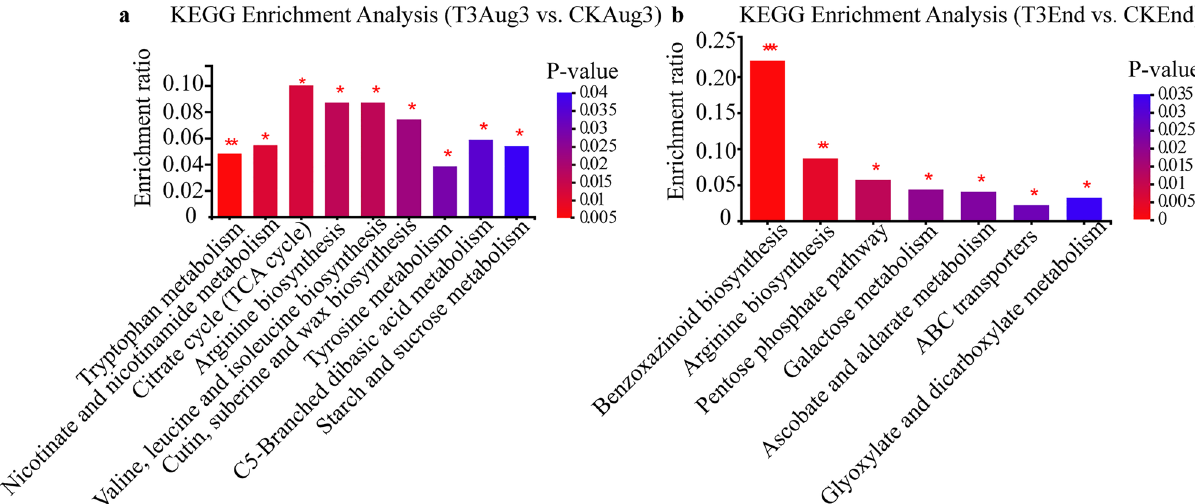
Figure 6. KEGG pathway enrichment analysis based on differentially abundant metabolites 21 . ( a ) T3Aug3 vs. CKAug3. ( b ) T3End vs. CKEnd. The horizontal coordinate is the name of the pathway, and the vertical coordinate indicates the enrichment ratio, which represents the ratio of the number of metabolites enriched in the pathway to the number of metabolites annotated to the pathway. T3Aug3 (samples from the T3 treatment on August 3rd), CKAug3 (samples from the CK treatment on August 3rd), T3End (samples from the T3 treatment on September 2nd) and CKEnd (samples from the CK treatment on September 2nd). A P value < 0.001 is marked ***, a P value < 0.01 is marked **, and a P value < 0.05 is marked (nonfluorescent chlorophyll catabolites), FCCs (fluorescent Chl catabolites) and RCCs (red Chl catabolites) are produced by chlorophyll degradation-related enzymes 24,25 . The green spots that occurred in the tobacco leaves of the wrapper variety CX-010 produced in the Enshi tobacco planting area directly impacted the consistency of the color of the tobacco leaves, thus affecting the availability of raw materials for cigars. In our study, spraying exogenous sucrose effectively limited the occurrence of green spots (Figs. 1,2). Although the fast appearance of green spots was accompanied by rapid water loss in all treatments, the water content of tobacco leaves in order was T3 < CK < T2 < T1, and the number of green spots in order was T3 < T2 < T1 < CK. It has been reported that sucrose possesses a moisturizing function at the appropriate concentrations 26,27 , which could be a possible expla- nation for why the T1 and T2 treatments had a higher total water content relative to the CK, which supported more chlorophyll degradation-related enzymes. However, the T3 treatment caused the largest limitation of green spot occurrence, which cannot be attributed to the change in the total water content. These results suggest that sucrose confers an unknown mechanism modulating the formation of green spots and that the total water content changes might be a result in sucrose concentration changes independent of green spot formation. Zhang et al. reported that the TCA and polyphenols biosynthesis pathways were associated with the response of tobacco plants to various salinity conditions, and the DAMs mainly included tyrosine, tryptophan and critic acid 28 . In this study, we found that the DAMs classification certainly agreed with Zhang’s study, suggesting that these DAMs predominantly occupy the metabolic pathways in leaf senescence. Yu et al. identified three sig- nificantly differentially enriched KEGG pathways in the green spotted tissues compared to the normal tissues, including tyrosine metabolism, phenylalanine metabolism, and flavonoid biosynthesis, and the chlorogenic acid accumulated in green spots as a chemical marker of green spot formation 4 . Chlorogenic acid is the main phenolic substance in tobacco and forms brown pigments such as quinones through enzymatic browning reactions dur- ing the air-curing process to transform the color of leaves 29 . In the present study, we did not find a difference in chlorogenic acid between the T3 treatment and CK (Supplementary Tables 1,2). One possible reason is that the samples used for metabolomics analysis were whole leaf tissue, and green spotted tissue only accounted for a small part. Thus, the dilution effect should be carefully considered in explaining the results of the present study. Tyrosine is an aromatic amino acid that is a precursor to metabolites such as tryptophan and phenylalanine, which finally produce natural products, including pigments, alkaloids, and hormones 30,31 . It was reported that the addition of tyrosine modulated the development of beetroot leaves and increased the carotenoid content 32 . T3 treatment induced the accumulation of phenylpropanoids such as tyrosine, tryptophan and some flavonoids in tobacco leaves; thus, the sucrose-stimulated phenylpropanoids metabolism must play an important role in differentially regulating the senescence and formation of green spots on air-curing tobacco leaves. On the other hand, the TCA cycle is a core pathway involved in the metabolic process of fatty acid synthesis, glucose hypo- plasia, transamination, and the synthesis of purines and pyrimidines 33,34 . Citric acid is the main intermediate metabolite of the TCA cycle, and Zahid et al. suggested that citric acid promoted plant growth and enhanced plant photosynthesis, thereby promoting chlorophyll formation 35 . All these results suggest that citric acid, tyrosine, and some metabolic pathways are involved in the conversion of pigments. In our study, T3 inhibited the accu- mulation of citric acid in the TCA cycle in tobacco leaves and promoted the accumulation of phenylpropanoids such as tyrosine and tryptophan. (Figs. 6,7). These results suggest that the reduced number of green spots in the